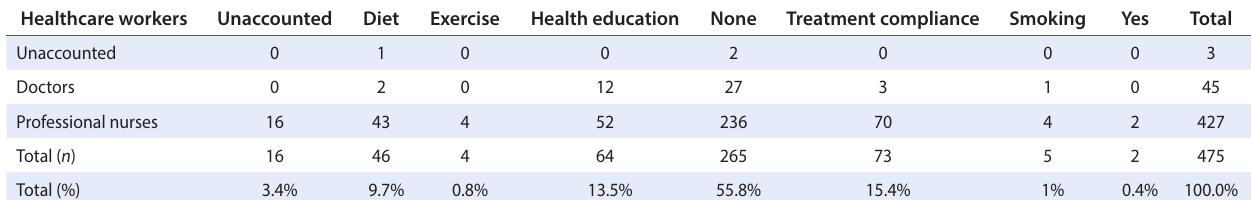
Table 8: Compliance with non-drug management by healthcare workers Healthcare